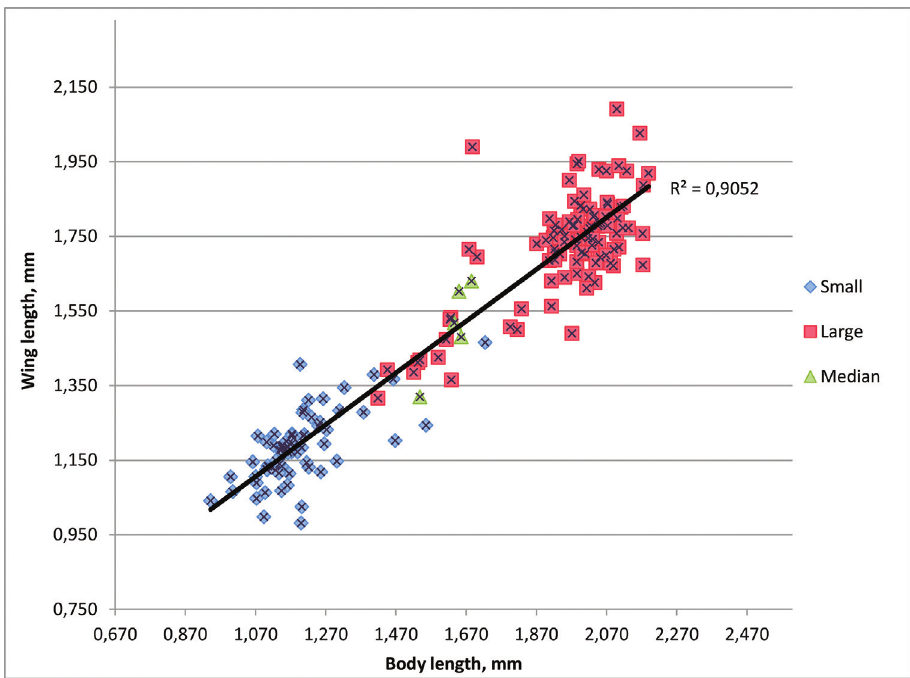
Figure 67. The specimens identified as Phanuromyia odo were originally split into two separate species, here labeled “small” and “large.” The trend line is calculated based on data for all specimens combined. The continuity in both variables and the overlap in specimens divided a priori into small and large catego- ries led to the conclusion that there is insufficient evidence to separate these specimens into two